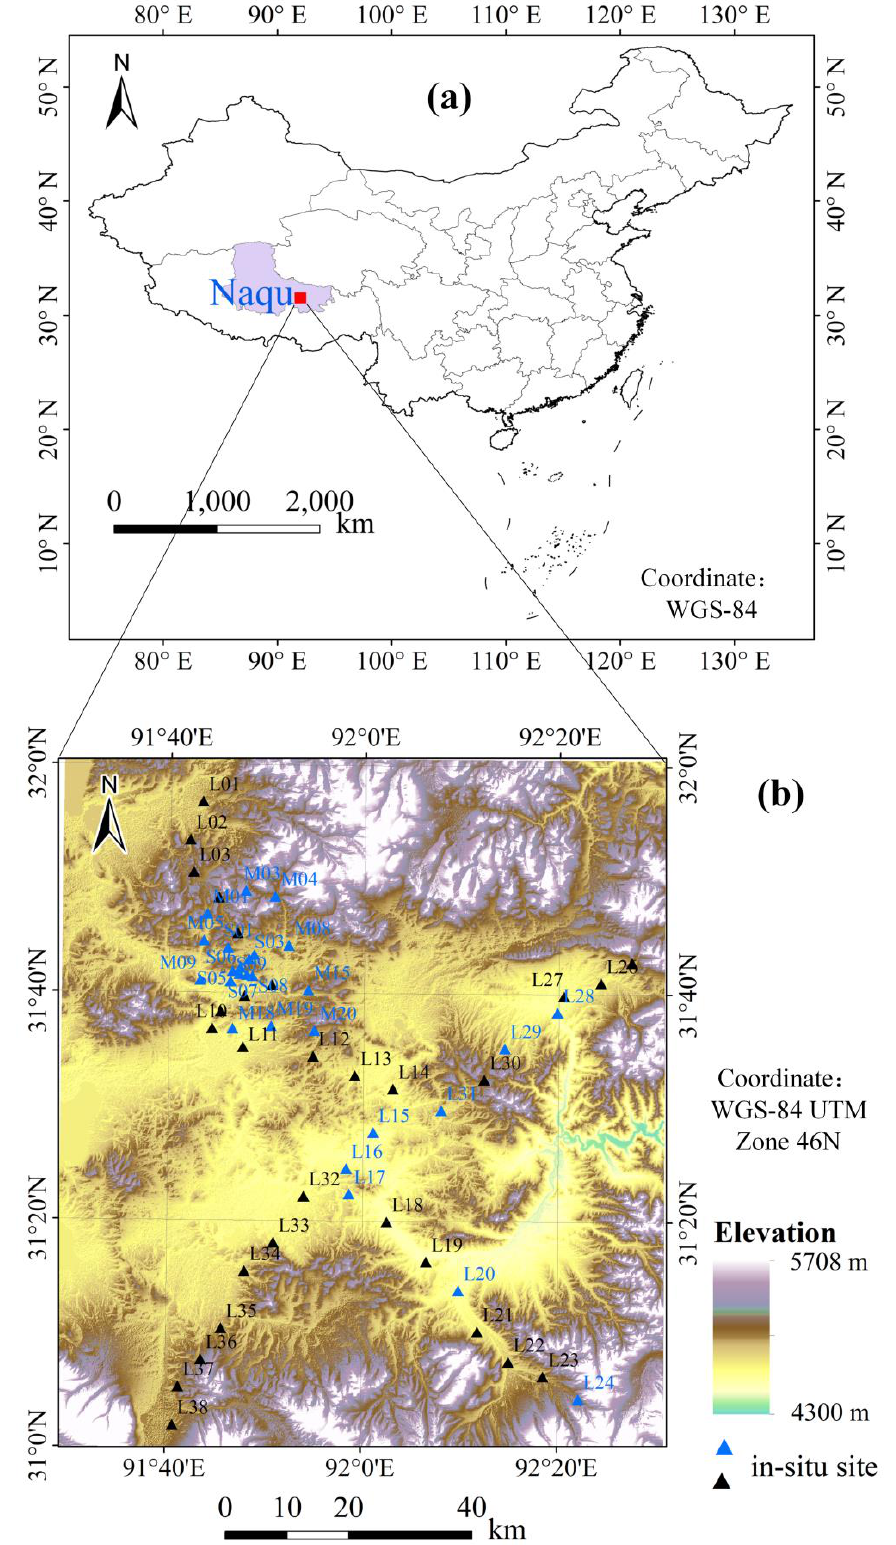
Figure 1. Location of the study area in southwest China ( a ) and the 57 in situ soil moisture sites ( b ). All in situ sites (in black and blue triangle) data is used for MODIS soil moisture retrieval and daily evaluation. The selected 29 in situ sites (in black triangle) data is used for temporal evaluation.